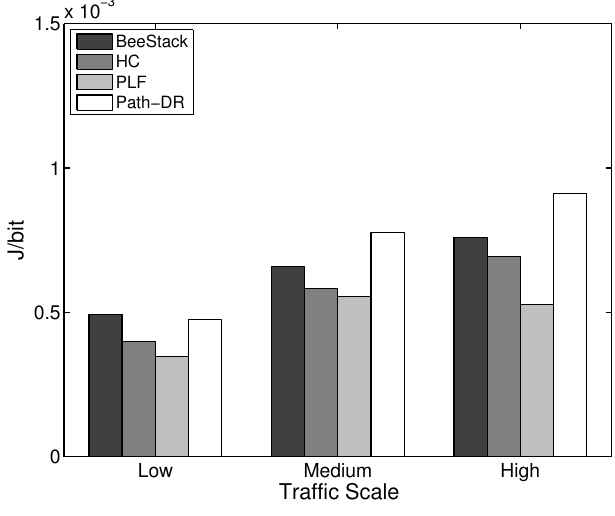
Figure 12. A comparison of the average energy efficiency for different routing metrics and traffic